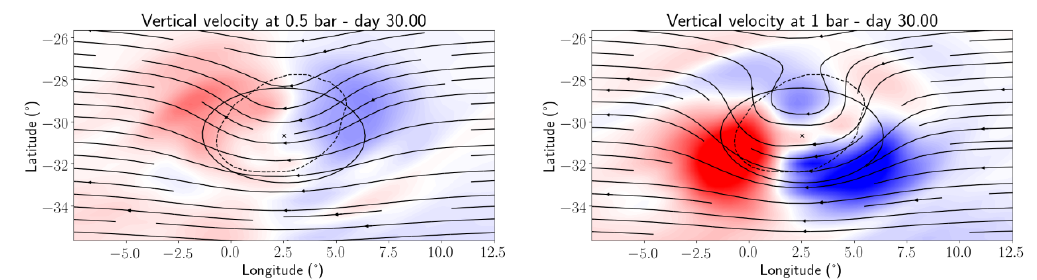
Figure 9. Wind field at 0.5 and 1 bar at day 30 for Simulation 21 with the horizontal field shown by streamlines and the vertical field represented by color, with red corresponding to upward velocities and blue downward with maximum color magnitude corresponding to 10